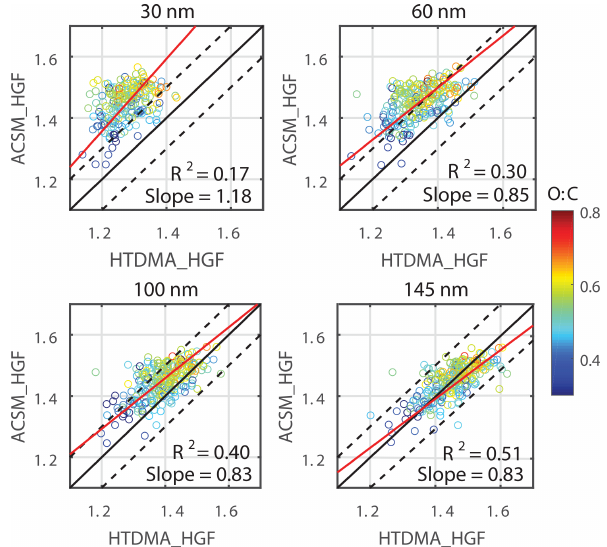
Figure 8. Closure study between the HTDMA-measured HGFs and the ACSM-derived HGFs. The black solid lines indicate the 1:1 line and the black dashed lines repre- sent ± 10% deviation, while the red lines are those fitted to the data points. The color bar indicates the O : C ratio of the organic aerosol fraction.